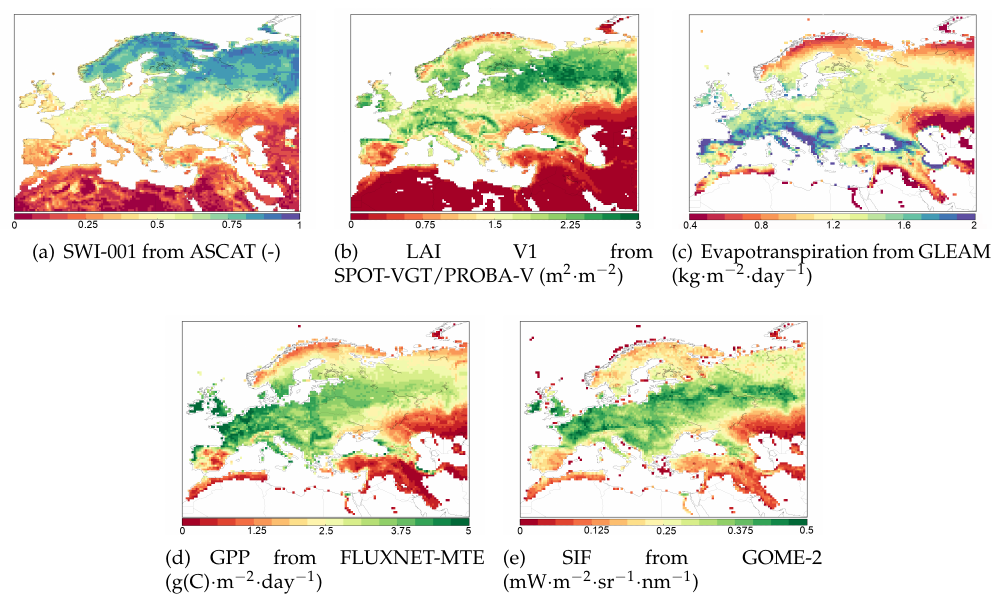
Figure 1. Averaged satellite-derived products for the whole period from 2007–2015: ( a ) original Soil Water Index (SWI); ( b ) Leaf Area Index (LAI); ( c ) evapotranspiration; ( d ) Gross Primary Production (GPP) and ( e ) Sun-Induced Fluorescence